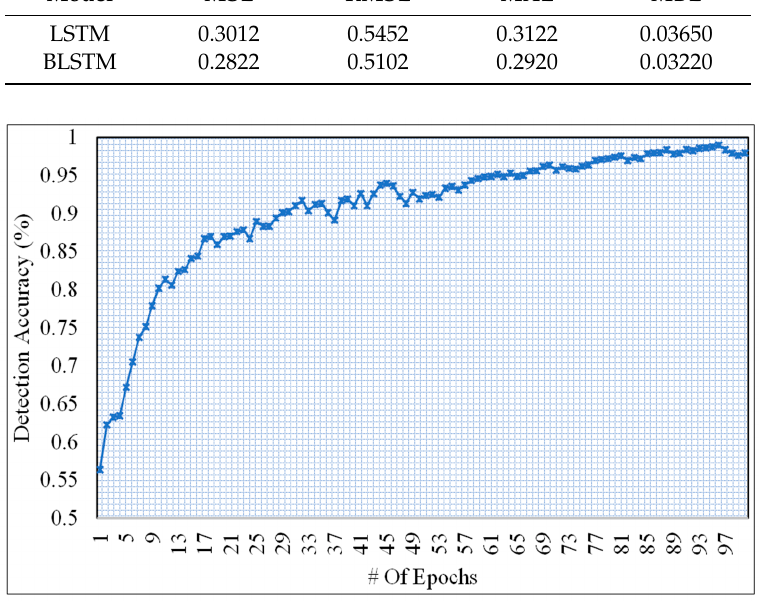
Figure 6. Prediction accuracy of BLSTM for 100 epochs.